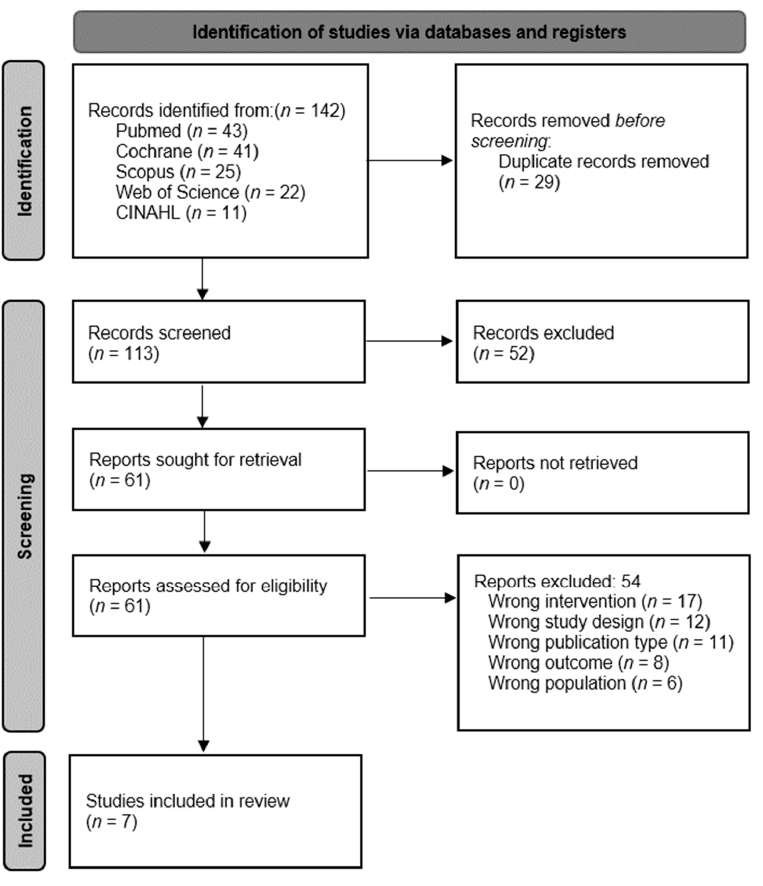
Figure 1. Flow diagram of the study selection process. Table 2. Risk of bias and methodological quality of the articles